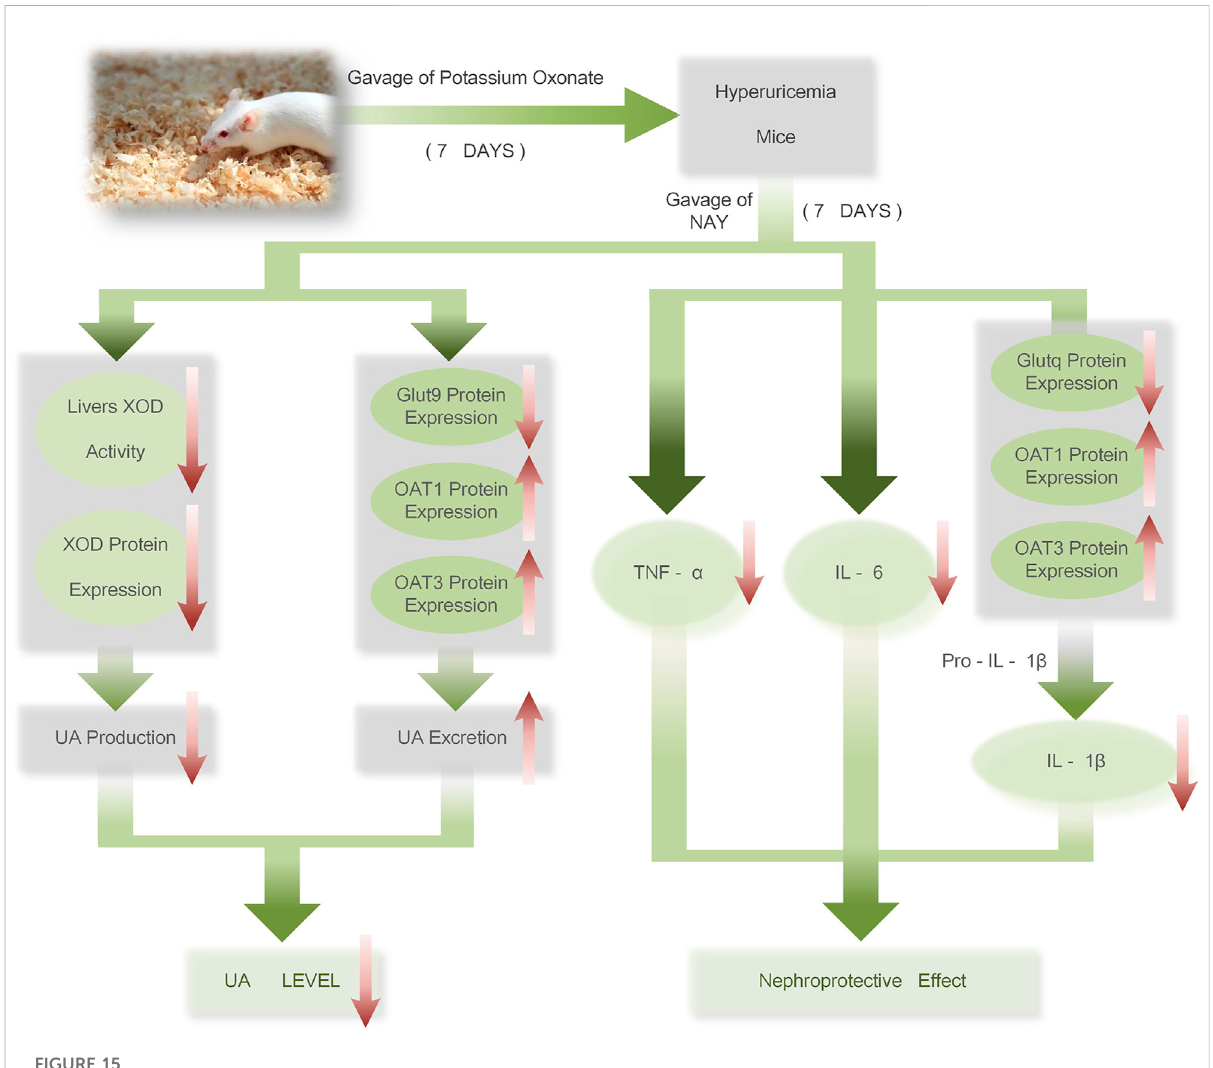
FIGURE 15 Therapeutic mechanism of NAY on hyperuricemia